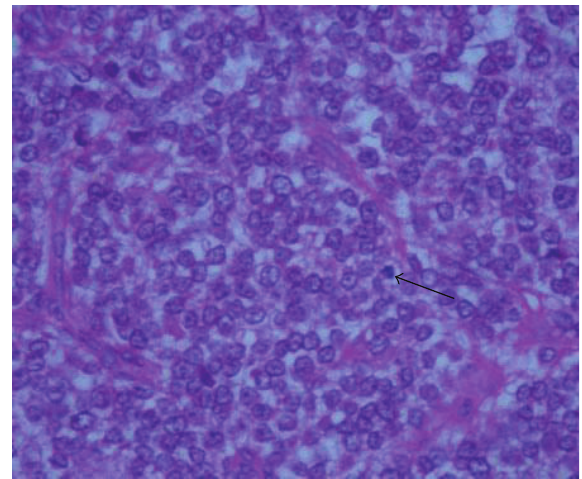
Figure 3: Microsection showing lobular arrangement of malignant round tumor cells with abundant vacuolated cytoplasm. Atypical mitosis also seen. Haematoxylin and Eosin (H&E) stain ×